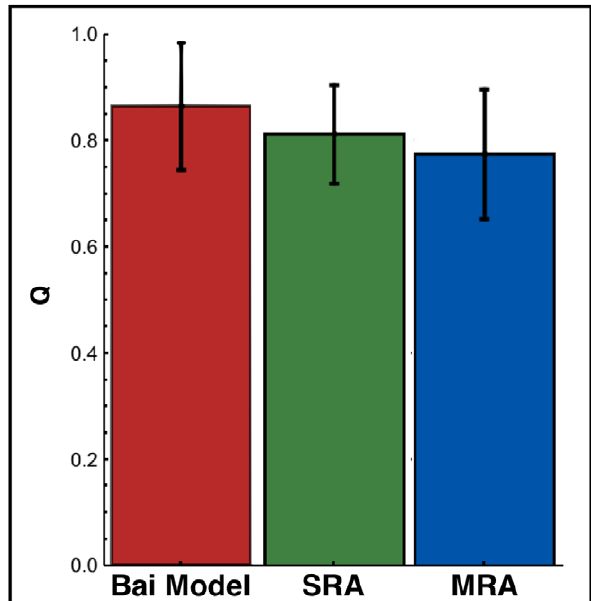
Figure 12. Relation between the incorrect and correct predic- tion, Q : The error bars represent the standard deviation obtained by a bootstrap technique. In this case, we evaluated the impact of the finite number of studied sequences on Q .